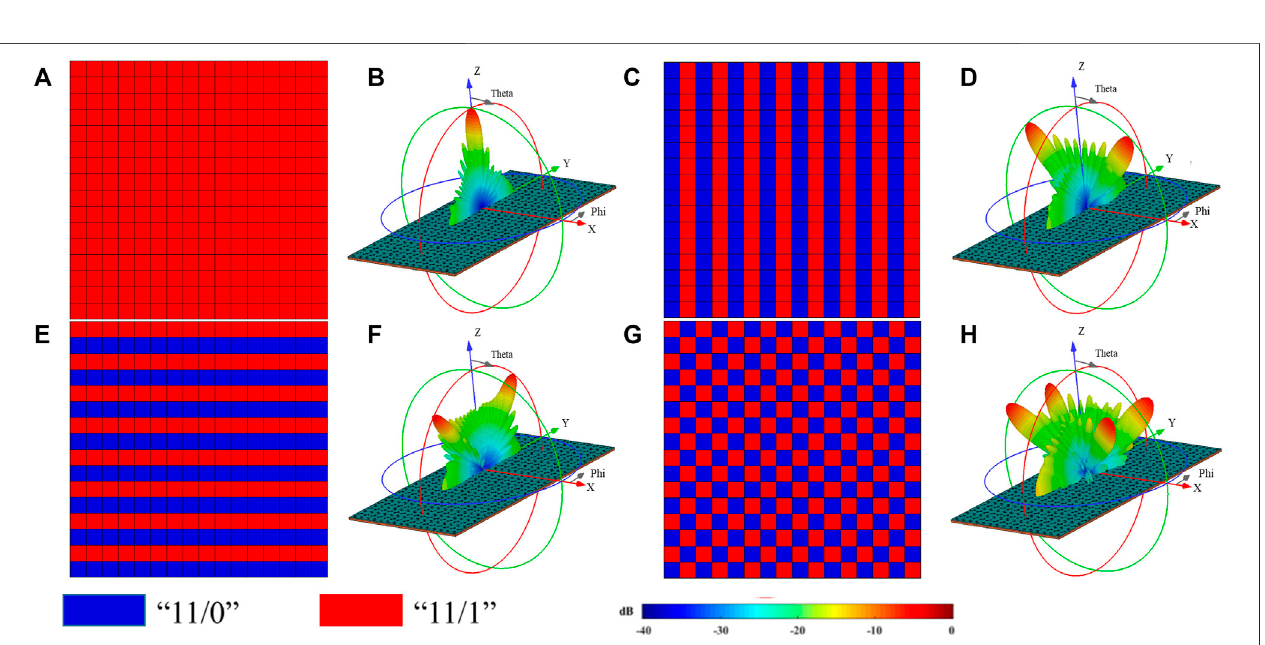
FIGURE 5 | Coding patterns and simulated x- polarized 3D scattering patterns under the y-polarized incident wave for manipulation of beam direction. (A , C , E,G) are coding patterns. (B , D , F , H) are corresponding 3D scattering patterns.